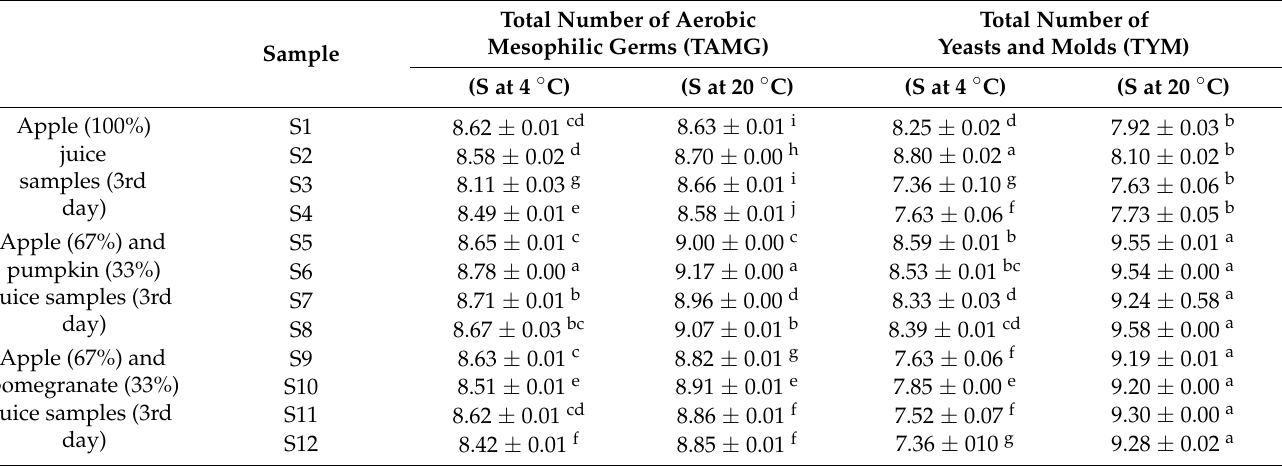
Table 7. Microbial growth in fruit juices during storage (S) at room and refrigeration temperatures (in log 10 CFU/cm 3